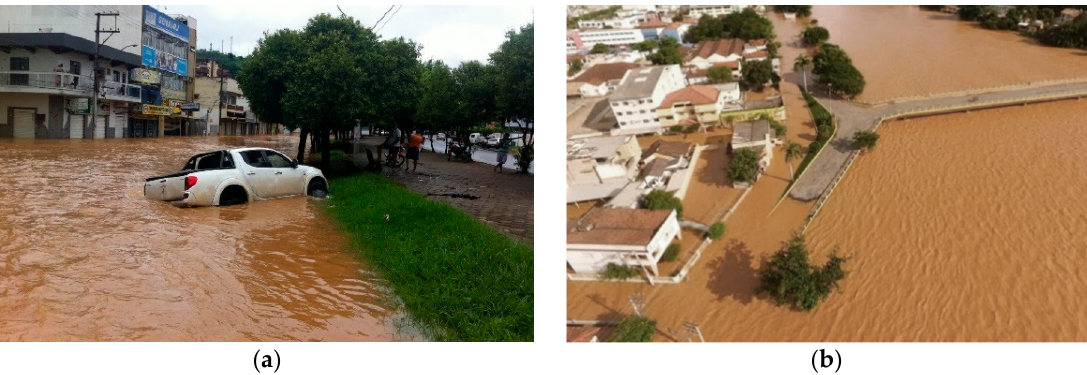
Figure 2. ( a ) National highway BR-356 at the center of Itaperuna in January 2012 [42]; ( b ) Muriaé River at Itaperuna in February 2020 [43].